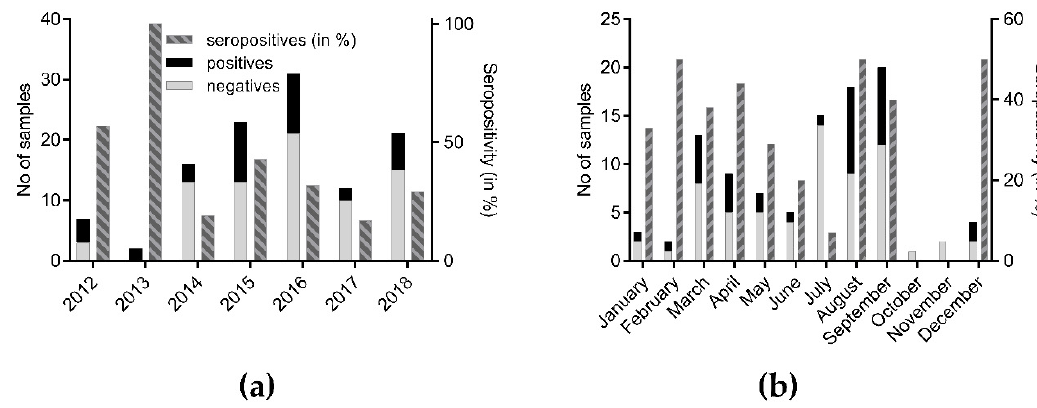
Figure 2. Total number of bat samples from Poland tested and seropositives (ELISA) thereof, stratified per year ( a ) and per month ( b ).